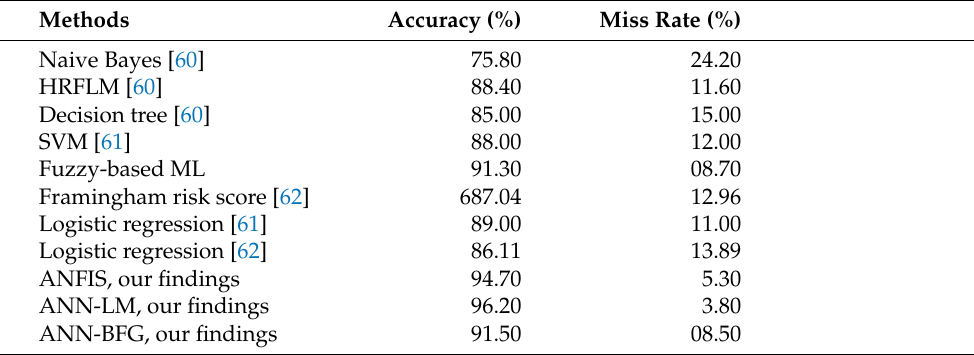
Table 13. Comparison of our findings with state-of-the-art